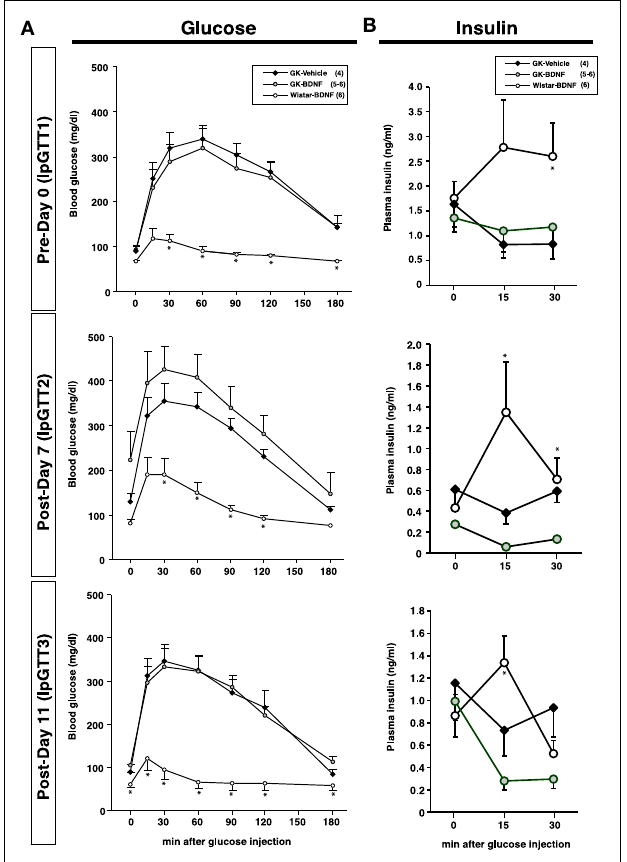
FIGURE 7 | Intraperitoneal glucose tolerance test before and after BDNF treatment in GK rats. BDNF treatment did not attenuate glucose intolerance (A) and impaired insulin release (B) during glucose tolerance test in GK rats throughout experiment. (A) ∗ p < 0 . 05 vs. GK-Vehicle and GK-BDNF (One-Way ANOVA with Holm’s post-hoc test). (B) ∗ p < 0 . 05 vs. GK-Vehicle in Day 0 (30min), Day 7 (15min), ∗ p < 0 . 05 vs. GK-BDNF in Day 7 (15min, 30min) and11(15min), One-Way ANOVAwithHolm’s post-hoc test.